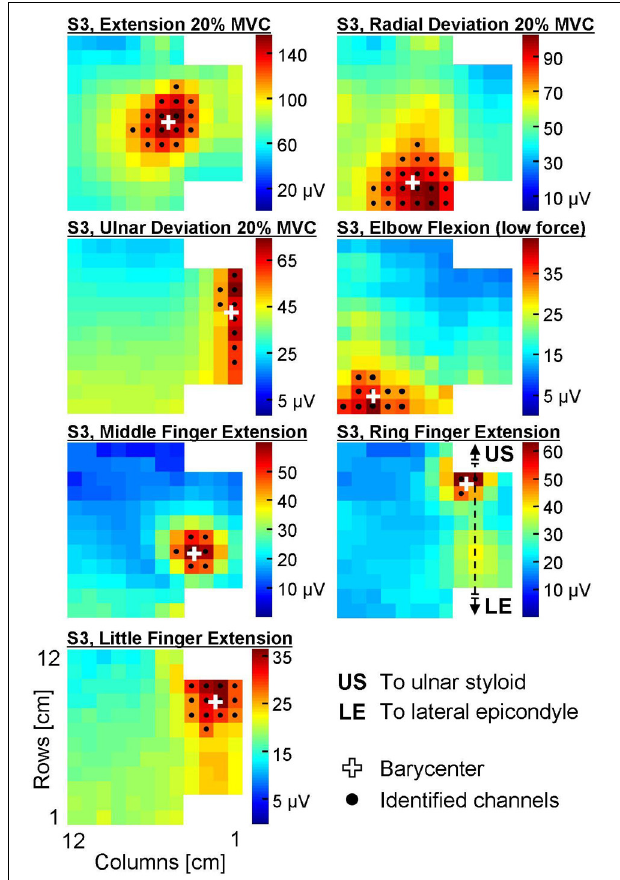
FIGURE 3 | Surface EMG amplitude distribution (RMS) over the skin during seven different contractions of a representative subject (S3). The colorbar of each map ranges between 0 and the peak amplitude of the map. Black dots identify the channels automatically identified with the segmentation algorithm, white crosses are the barycenters of these channels.